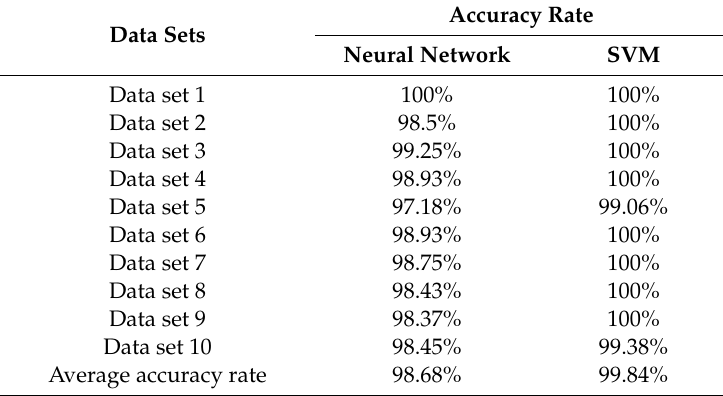
Table 4. Results of the fabric pilling grade in the second experiment using the proposed DPCANN